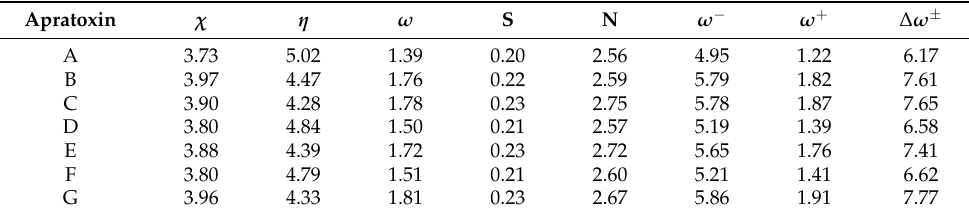
Table 2. Global reactivity descriptors for the Apratoxins A–G family of marine cyclopeptides (all in eV, with the exception of S, in eV − 1 ).